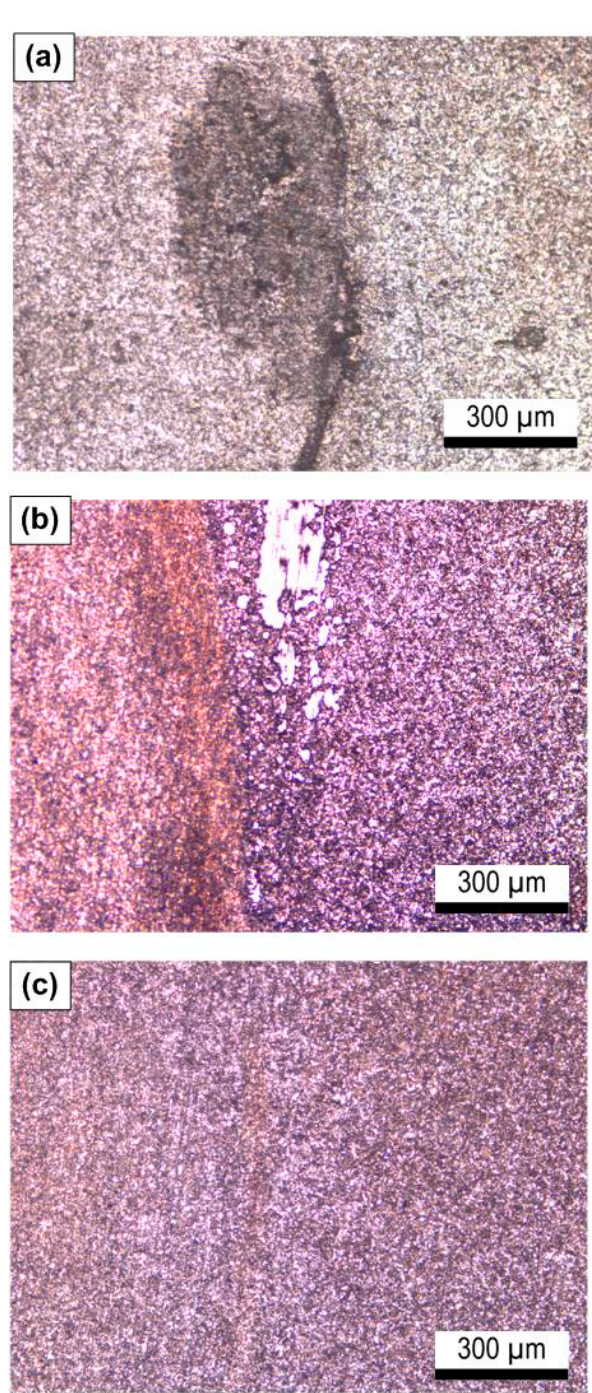
Figure 9. Optical microscope images of boundary covered (left side) and uncovered (right side) ( a ) α -FeOOH, ( b ) Fe 3 O 4 and ( c ) Fe 2 O 3 iron oxides deposit, after potentiostatic tests under − 650 mV SCE for 20 h in the simulated district heating water at 40 °C.